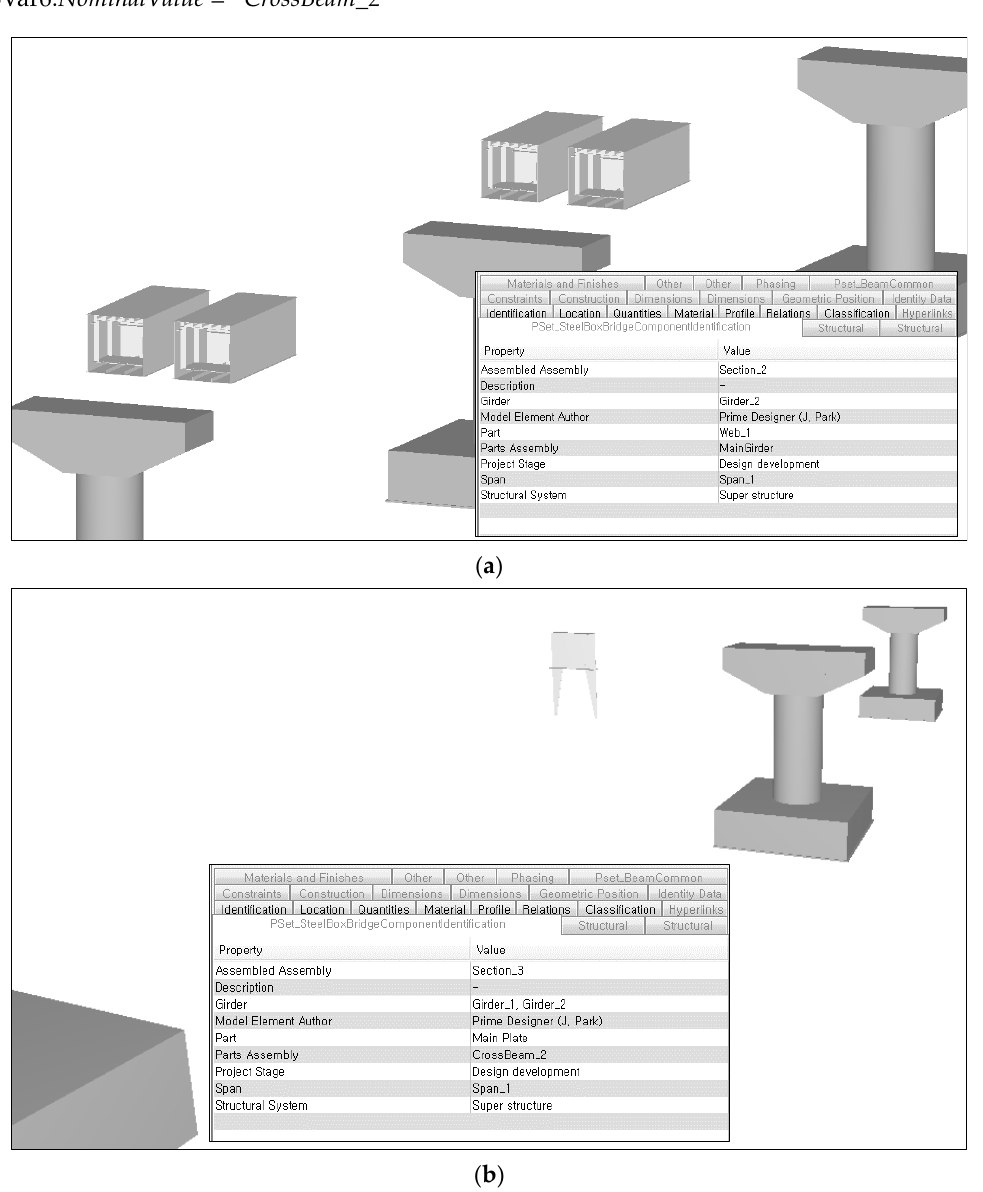
Figure 17. Query result for extracting specific objects from the bridge model (the pier objects were deliberately added for check the locations of the responded results): ( a ) All Section_2 objects; and ( b ) CrossBeam_2 object.